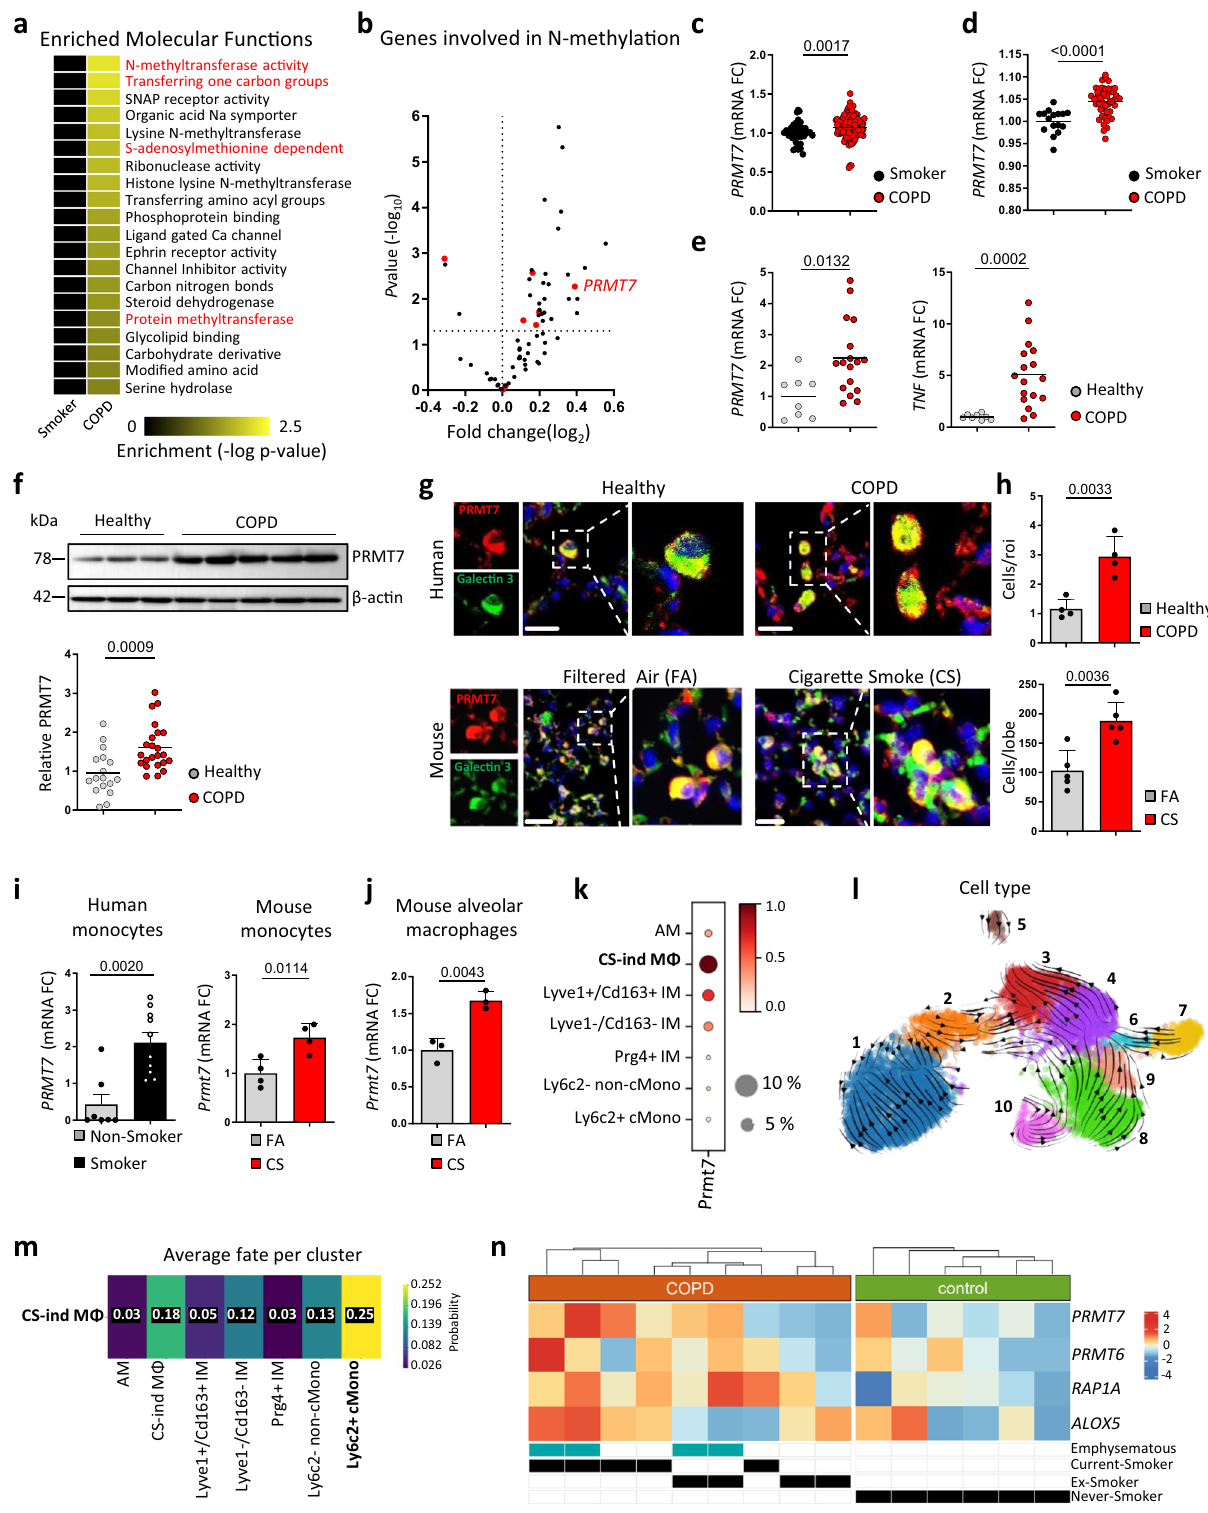
information given by RNA velocity, revealed that CS-induced macrophages originated from classical in fl ammatory monocytes and differentiate toward a monocyte-derived alveolar macrophage phenotype (Fig. 1l, m). Inline, there was an increase in the percentage of monocyte-like macrophages in the bronchoalveolar lavage of COPD patients compared to healthy controls following scRNA-seq analysis (Supplementary Fig. 3d), with greater PRMT7 NATURE COMMUNICATIONS| (2022) 13:1303